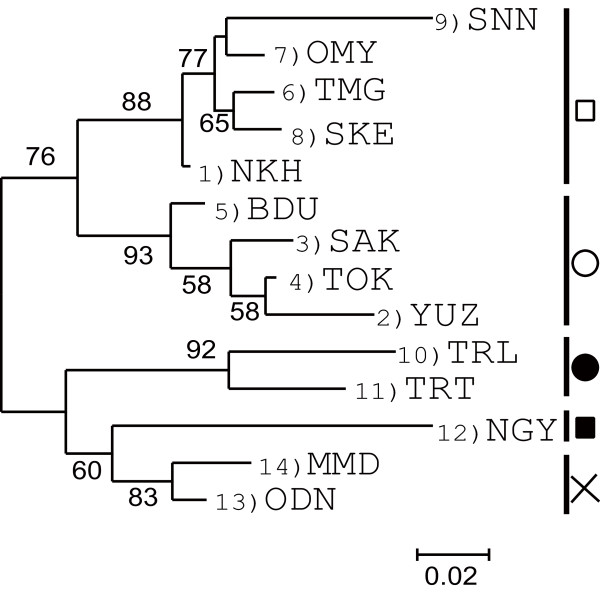
Neighbour-joining tree of Platypus quercivorus generated using Nei et al.'s distances DA [35]. Five major clades labelled in symbols correspond to the SAMOVA (K = 5) shown in Fig 2. Bootstrap percentages from 1,000 replicates are noted for each branch; only bootstrap values >50% are shown.